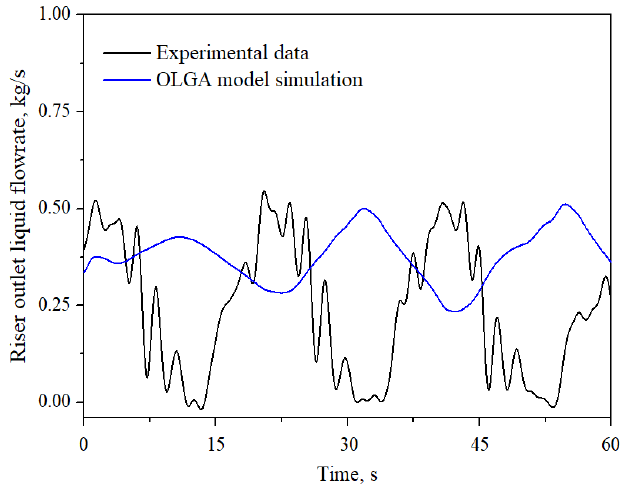
Figure 17. Experimental and simulated liquid production trends during choking-induced slug flow ( U GS = 0.08 m/s and U LS = 0.09 m/s).